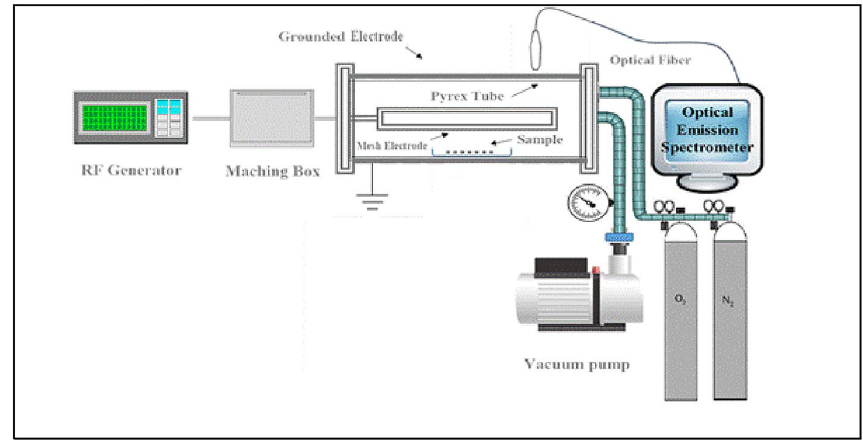
Figure 1. Process of treating wheat seeds by the RF plasma device.